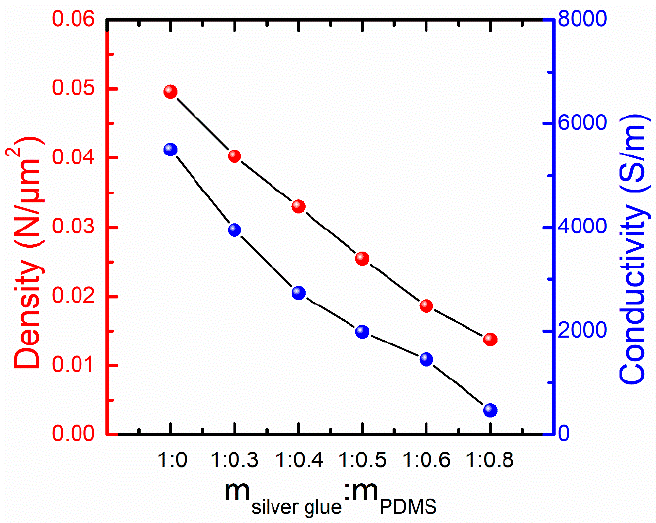
Figure 6. Conductivity of the electrode and density of Ag nanosheets in the electrode containing different ratios of silver glue and PDMS.